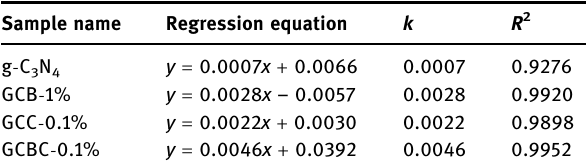
Table 1: Linear fi tting data of photocatalytic reaction kinetics for each sample